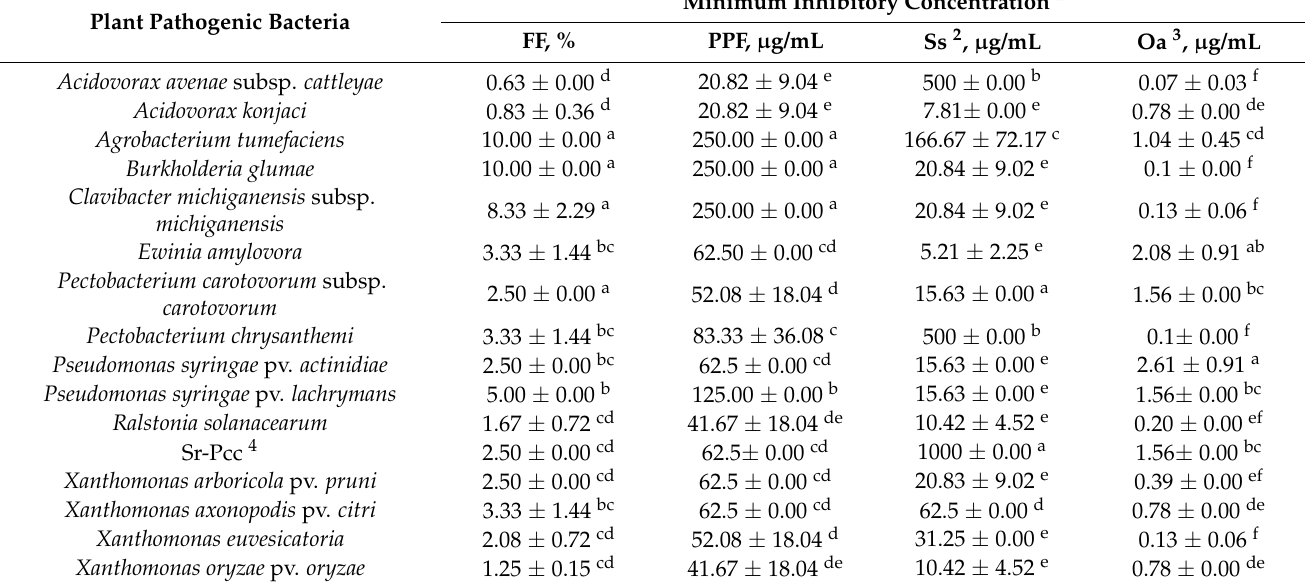
Table 1. In vitro assay of antibacterial activity of the fermentation filtrate (FF) and the partially purified fraction (PPF) of Streptomyces sp. AN090126 that compared with commercial products against various plant pathogenic bacteria.